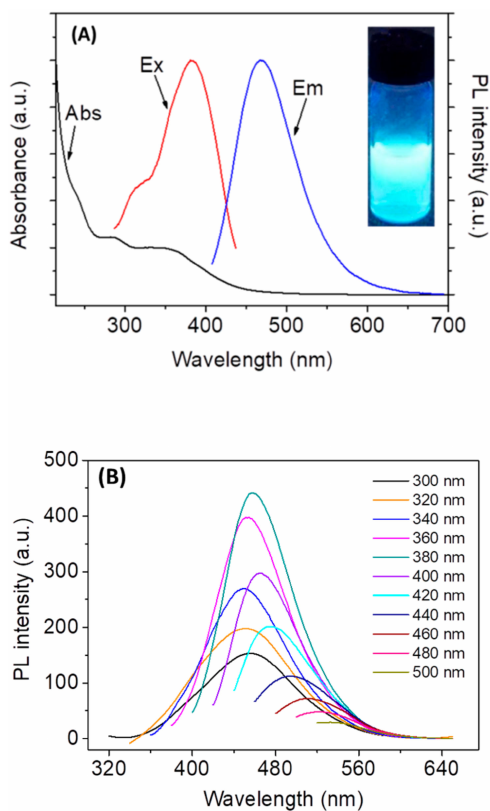
Figure 2. ( A ) The UV-vis absorption (black line), excitation (red line), and emission (blue line) spectra of N , Cl -CDs in aqueous solution (0.10 mg/mL). The inset shows the photograph of N , Cl -CDs aqueous solution (0.10 mg/mL) under UV light; ( B ) the PL spectra of N , Cl -CDs at different λ ex